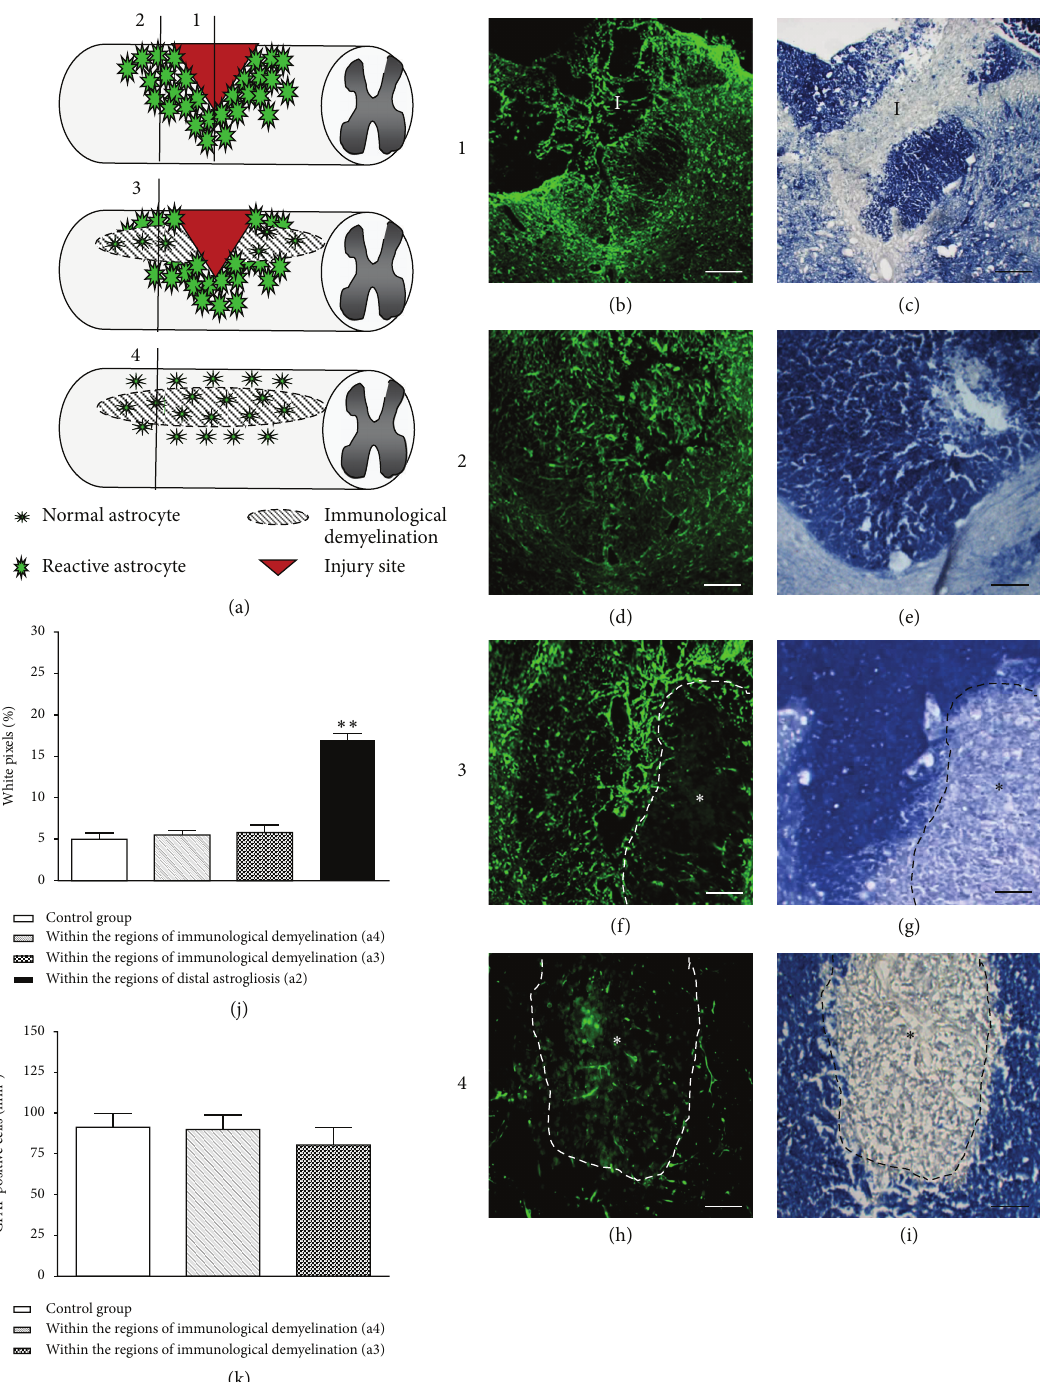
Figure 5: Immunological demyelination attenuates the induction of distal reactive. (a) Schematic drawing of different experimental groups and where analysis of white pixel and GFAP-positive cell counts were conducted. (b) GFAP-stained serial section to (c). The injury site is surrounded by wide spread astrogliosis in the gray and the white matter. (c) Eriochrome cyanine R-stained transverse section showing the injury site (I). (d) GFAP-stained serial section to (e). Astrogliosis is still evident 1mm rostral the injury epicenter. (f) GFAP-stained serial section to (g). (f) Astrogliosis is markedly reduced within the region of demyelination ( ∗ , hatched line). (e) Eriochrome cyanine R-stained transverse section showing the region of demyelination 1mm rostral the injury epicenter. (j) Whereas there is a significant increase in % of GFAP staining 1mm rostral to the injury epicenter, regions of immunological demyelination showed a similar percentage of GFAP staining compared to normal white matter. (k) The numbers of GFAP-positive cells within regions of immunological demyelination either alone or 1mm rostral to the injury epicenter are similar compared to those of the normal dorsal column. ∗∗ : 𝑃 < 0.01 . Scale bars: (b)-(c) 100 𝜇 m; (d)–(i) 50 𝜇